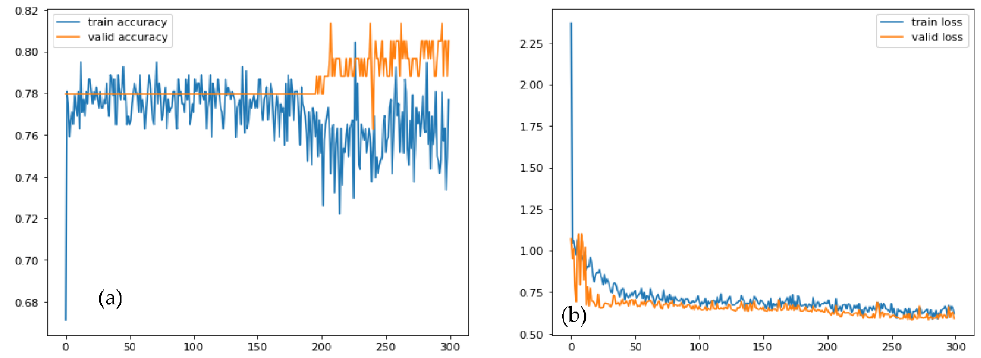
Figure 6. ( a ) Training and validation accuracy, ( b ) Training and validation loss graphs of the proposed architecture. Table 2. Classification results of the Proposed CVT-Trans system model based on 10-fold cross validation on selected dataset.